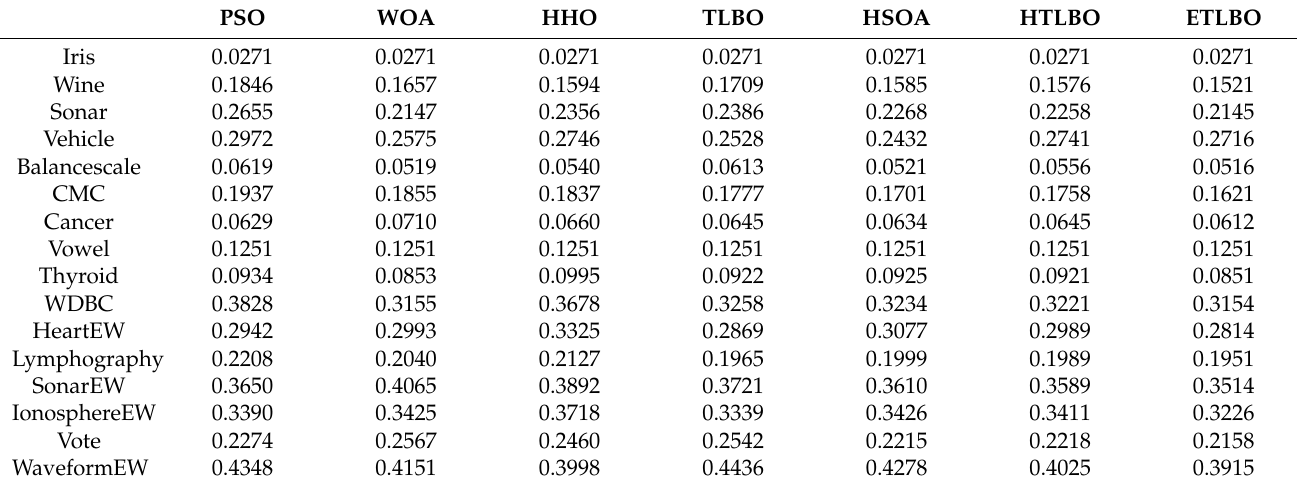
Table 2. The fitness values of compared algorithms.